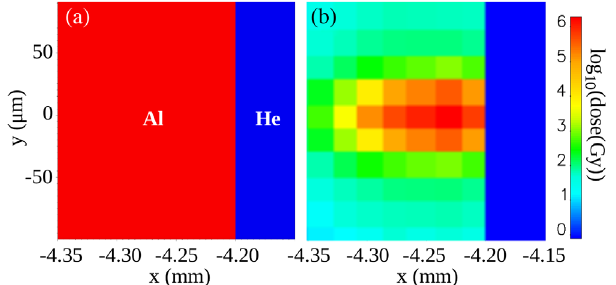
FIG. 7. (a) FLASH 2D simulation domain (initial condition) and (b) the MARS dose map overlaid on the same region.